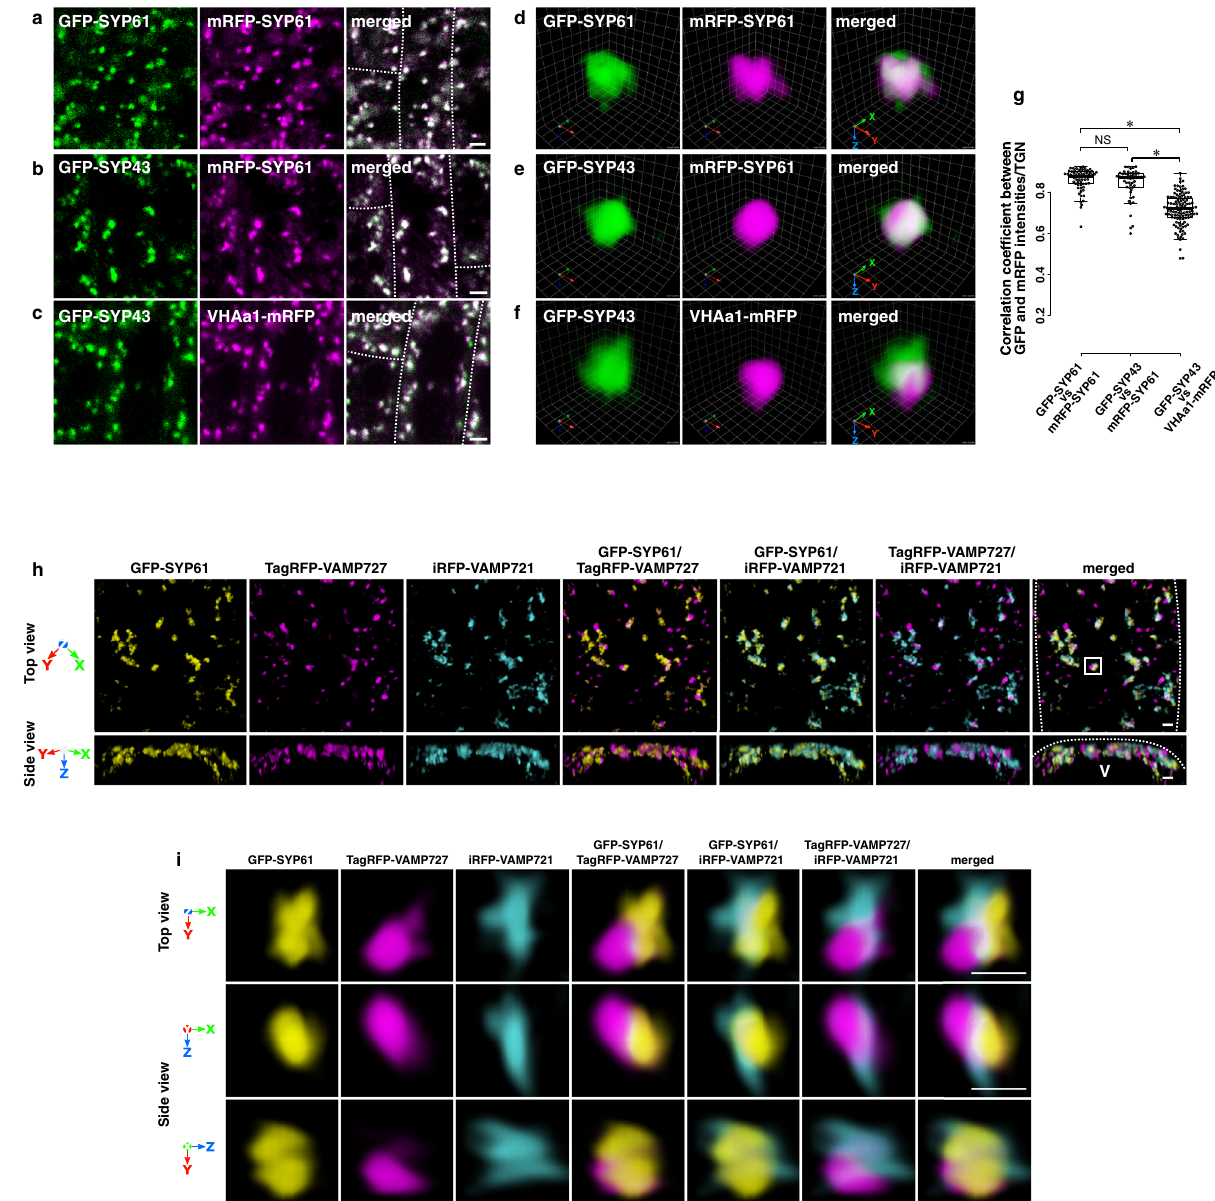
Fig. 1 Differential distribution of TGN-localized proteins. a – f Confocal images under conventional CLSM ( a – c ) or 3D images under SCLIM ( d – f ) of GFP- SYP61 and mRFP-SYP61 ( a , d ), GFP-SYP43 and mRFP-SYP61 ( b , e ), or GFP-SYP43 and VHAa1-mRFP ( c , f ) in the epidermal cells of the root elongation zone. g 3D colocalization analysis of the TGN markers: n = 64, 50, and 118 TGNs for GFP-SYP61 vs mRFP-SYP61, GFP-SYP43 vs mRFP-SYP61, and GFP- SYP43 vs VHAa1-mRFP, respectively, from fi ve or more biological replicates. Two-sided Steel-Dwass test; P = 0.86 (Left: GFP-SYP61× mRFP-SYP61 vs GFP-SYP43 × mRFP-SYP61), P = 3.0 × 10 − 14 (Top: GFP-SYP61 × mRFP-YP61 vs GFP-SYP43× VHAa1-mRFP), and P = 2.2 × 10 − 7 (Right: GFP-SYP43 × mRFP-SYP61 vs GFP-SYP43 × VHAa1-mRFP); * P < 0.01, NS = nonsigni fi cant. Boxes represent 25% and 75% quartiles, lines within the box represent the median, and whiskers represent the minimum and maximum values within 1.5× the interquartile range. h 3D images of GFP-SYP61, TagRFP-VAMP727, and iRFP-VAMP721 in the epidermal cell of the root elongation zone under SCLIM. i Multi-angle magni fi ed 3D images of GFP-SYP61, TagRFP-VAMP727, and iRFP-VAMP721 of the boxed area in h . Upper panels: top view; middle and lower panels: side view ( h , i ). The experiments were repeated at least fi ve times independently with similar results, and micrographs from representative experiments are presented. Scale bars = 5 μ m ( a – c ); 1 μ m ( h , i ). Grid width = 0.234 μ m ( d – f ). Dashed lines indicate cell edges. V, vacuole